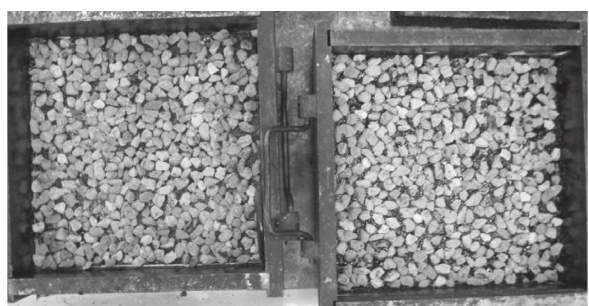
Figure 1: The laying of SAMI on the concrete slab.